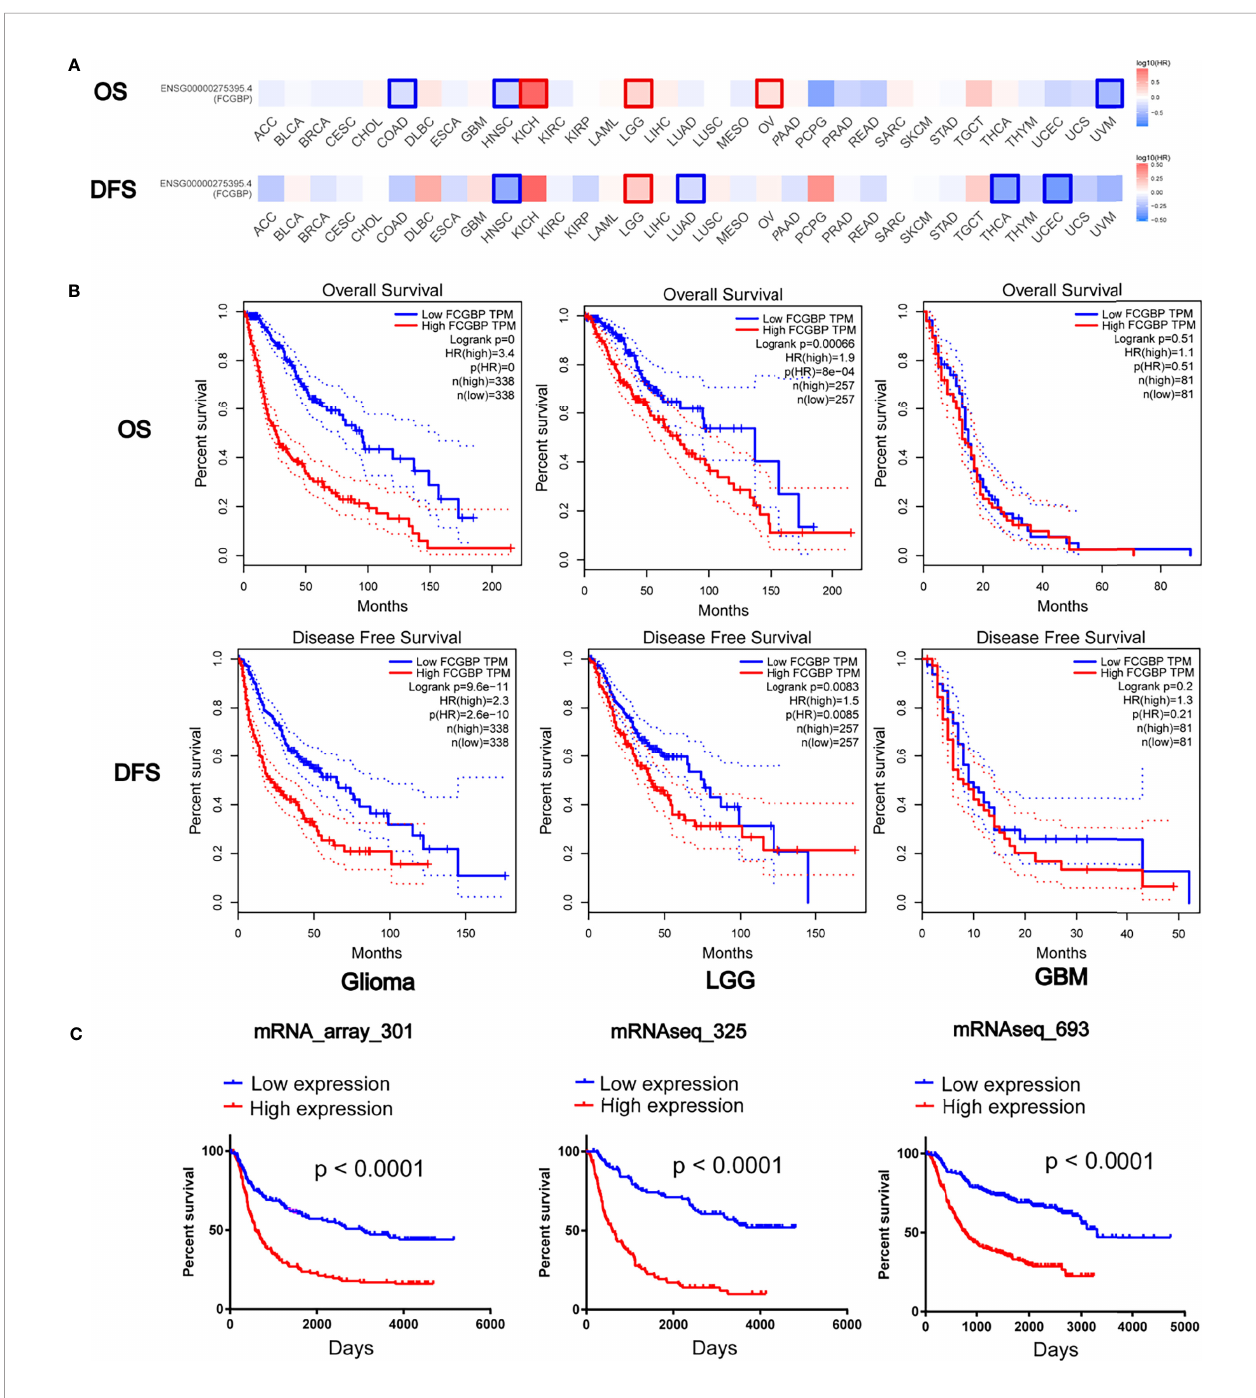
FIGURE 3 | Prognostic potential of FCGBP in glioma. (A) The OS and DFS Map of FCGBP in different cancers by GEPIA. (B) Kaplan ‐ Meier survival analysis of all glioma, LGG and GBM in TCGA data sets. (C) Kaplan ‐ Meier survival analysis of all glioma in CGGA data